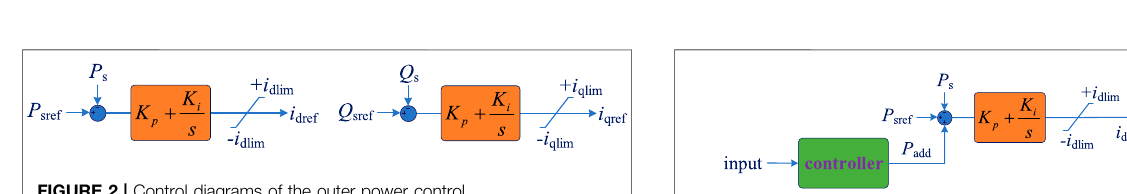
FIGURE 2 | Control diagrams of the outer power control.